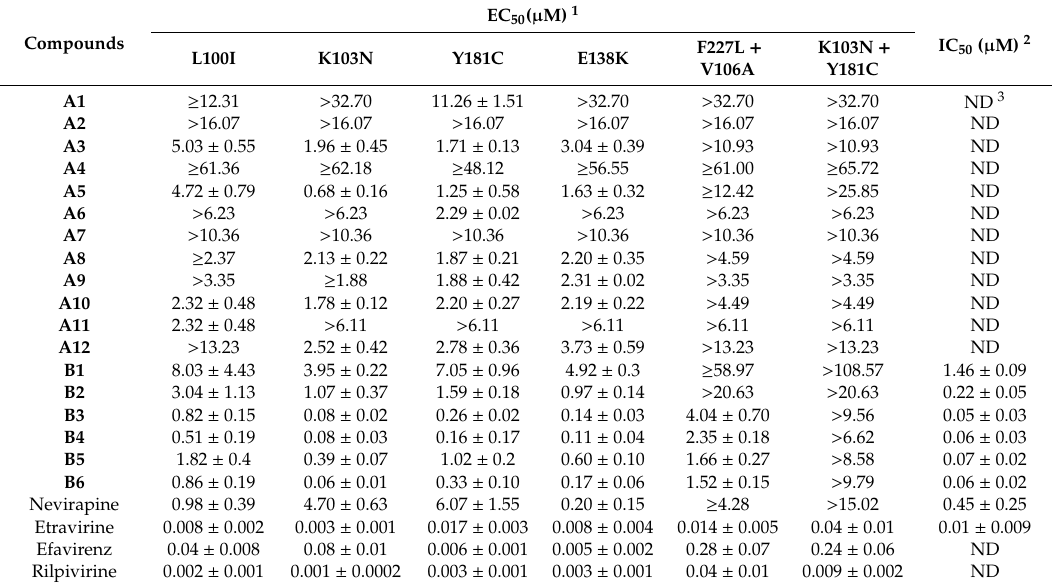
Table 3. Inhibitory activity of compounds A1 – A12 and B1 – B6 toward a panel of clinically relevant HIV-1 mutant strains and inhibitory activity of compounds B1 – B6 toward WT HIV-1 RT. EC 50 ( µ M) Compounds